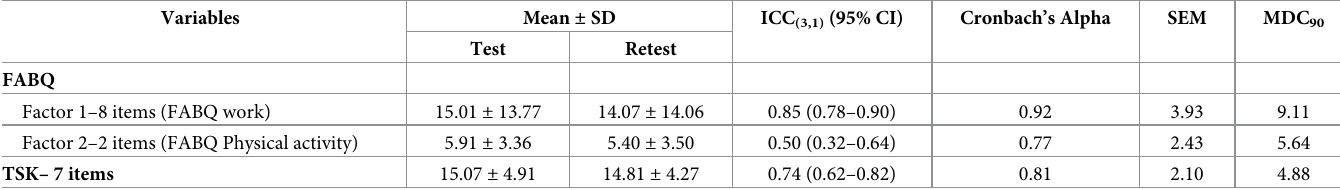
Table 4. Reliability and internal consistency analysis of Fear-Avoidance Beliefs Questionnaire and Tampa Scale of Kinesiophobia (n = 86). Variables